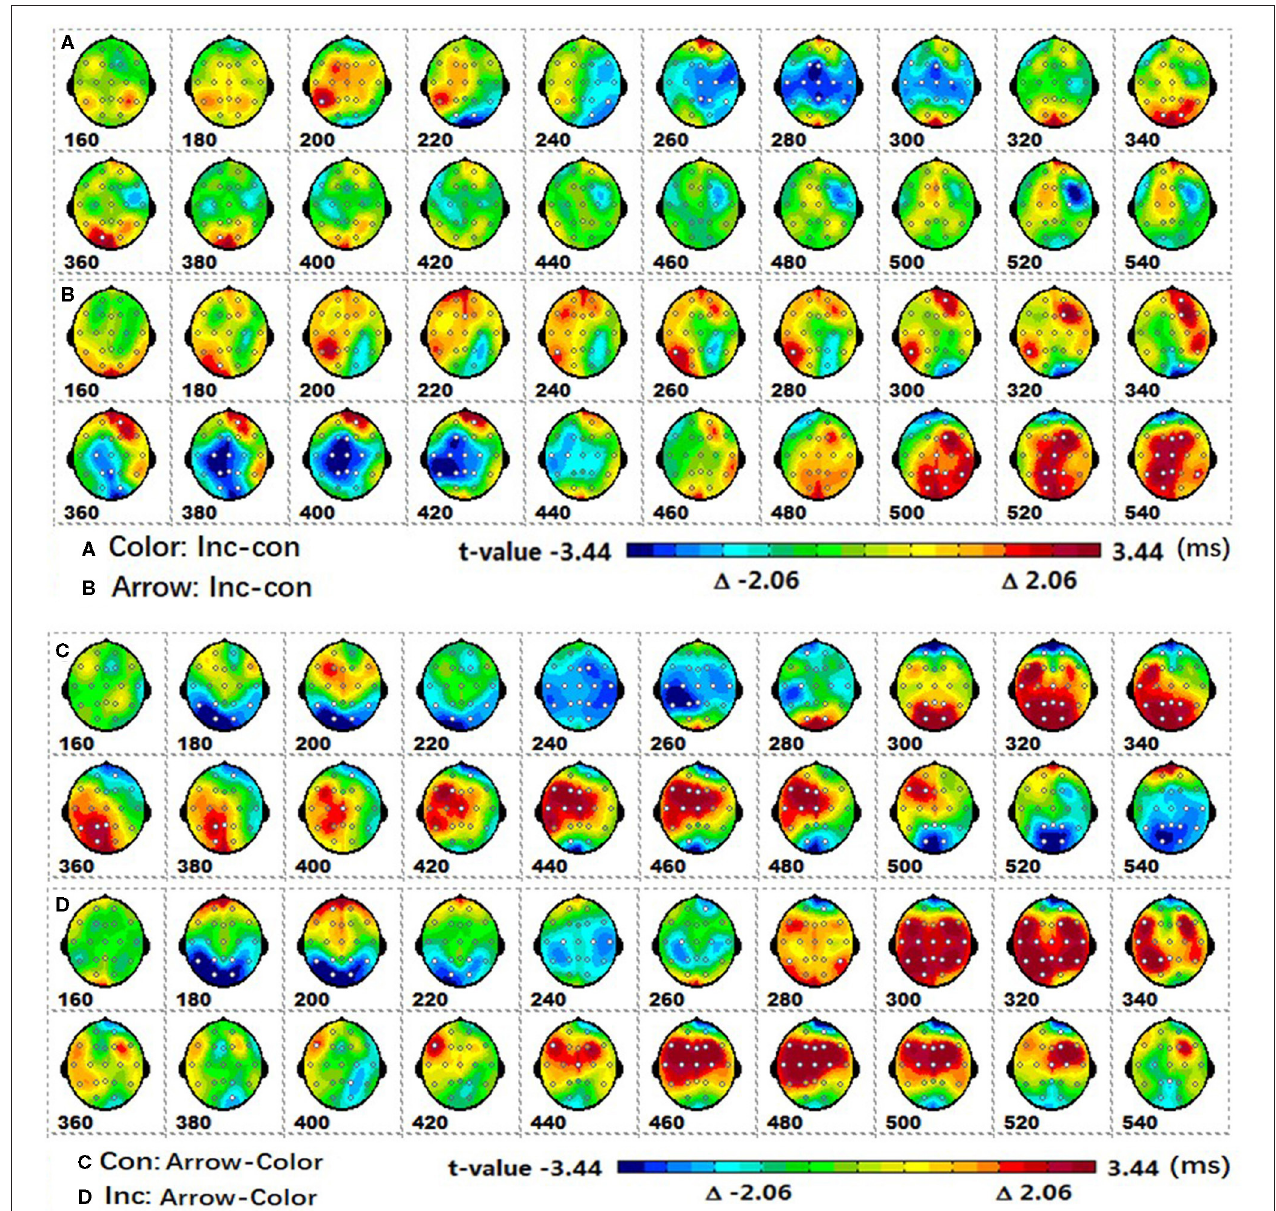
FIGURE 4 | The spatiotemporal patterns of SPM ( t ) from 160 to 540ms are derived from the pairwise comparisons between the conditions (Col, Arr, Con, Inc): (A) (Col.Inc-Col.Con), (B) (Arr.Inc-Arr.Con), (C) (Con.Arr-Con.Col), (D) (Inc.Arr-Inc.Col). Each map is interpolated from the average t -values within window length of 20ms; the white dots represent the sites with significant effects. For the spatiotemporal patterns of SPM ( t ), the colors beyond the 0.05 significant threshold t (24) = 2.06 at the two ends of the color scale represent significant regions. Col, color; Arr, arrow; Con, congruent; Inc,